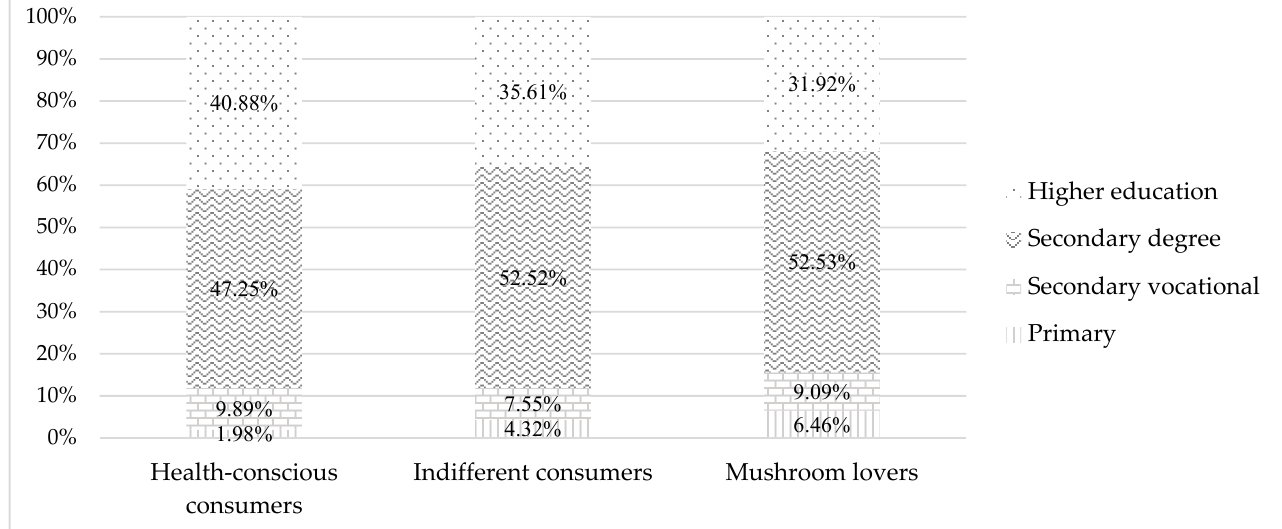
Figure 6. Distribution by educational level within clusters generated based on level of consciousness in mushroom consumption.